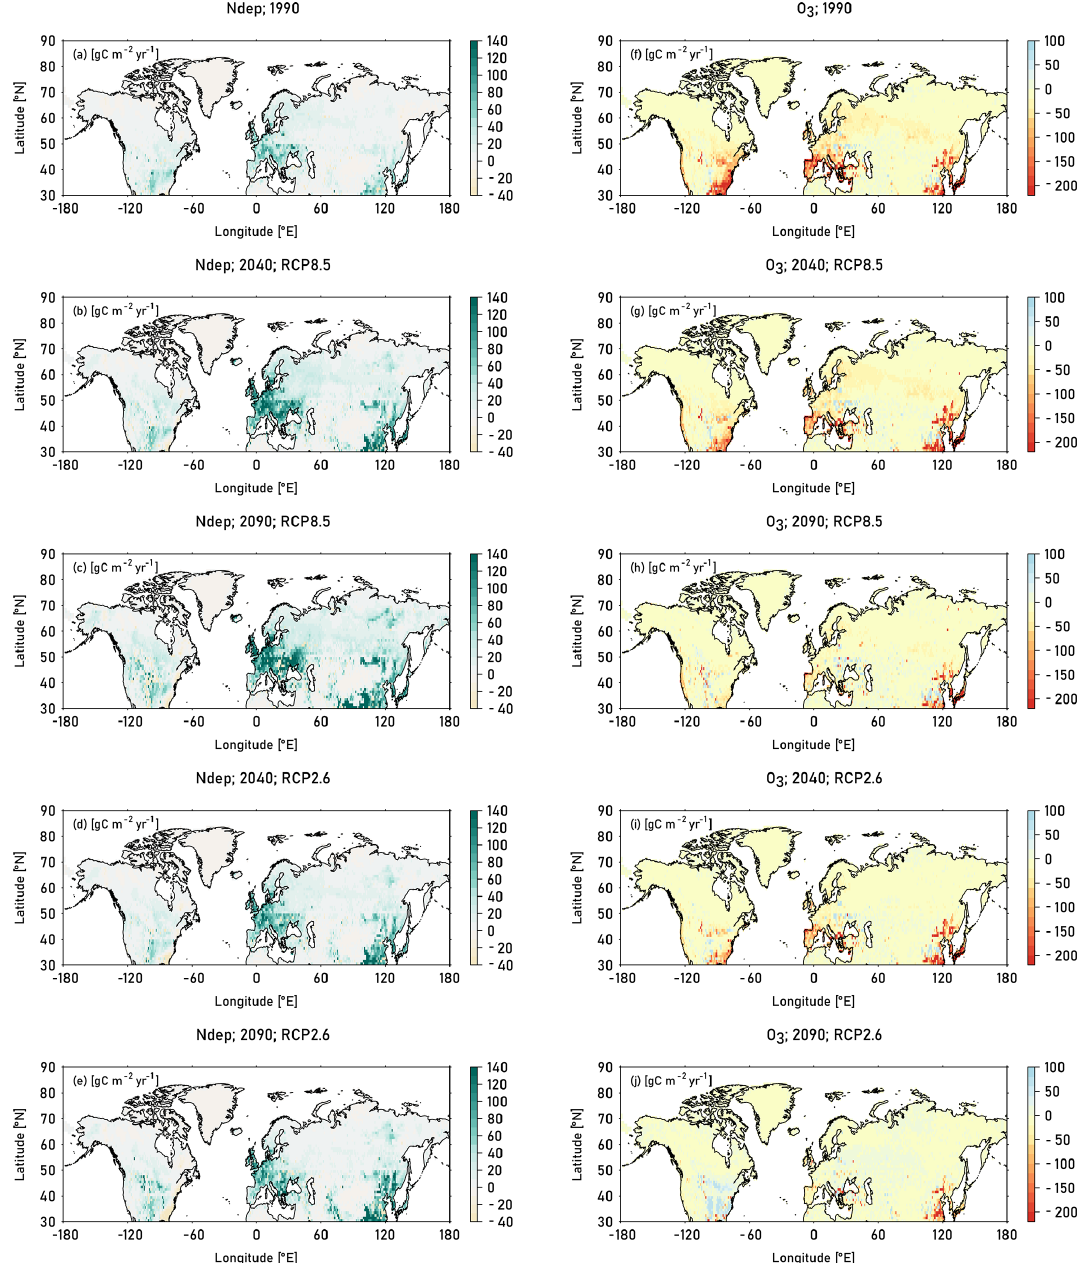
Figure 8. Absolute change in GPP compared to preindustrial values induced by nitrogen deposition (left column) and O 3 calculated according to approach 2 (right column). The induced change in GPP is displayed for the decades 1990 (mean of the years 1990–1999), 2040 (mean of the years 2040–2049), and 2090 (mean of the years 2090–2099). For the decades 2040 and 2090, results from simulations based on RCP8.5 and RCP2.6 are displayed. See Table 2 for details on the calculation of the single